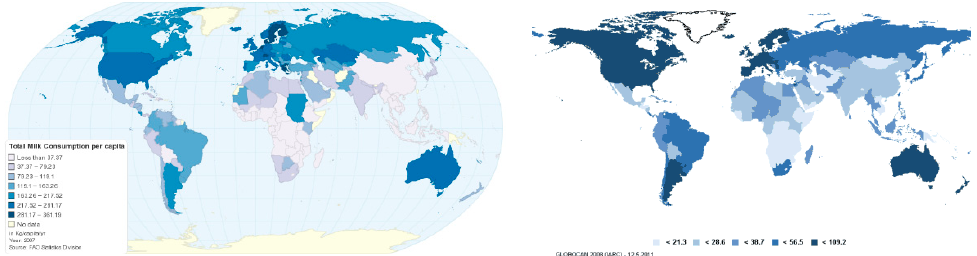
Figure 1. Global geographical comparison of milk consumption with breast cancer incidence. Left: Estimated milk consumption (2008) [17]; Right: Estimated breast cancer incidence